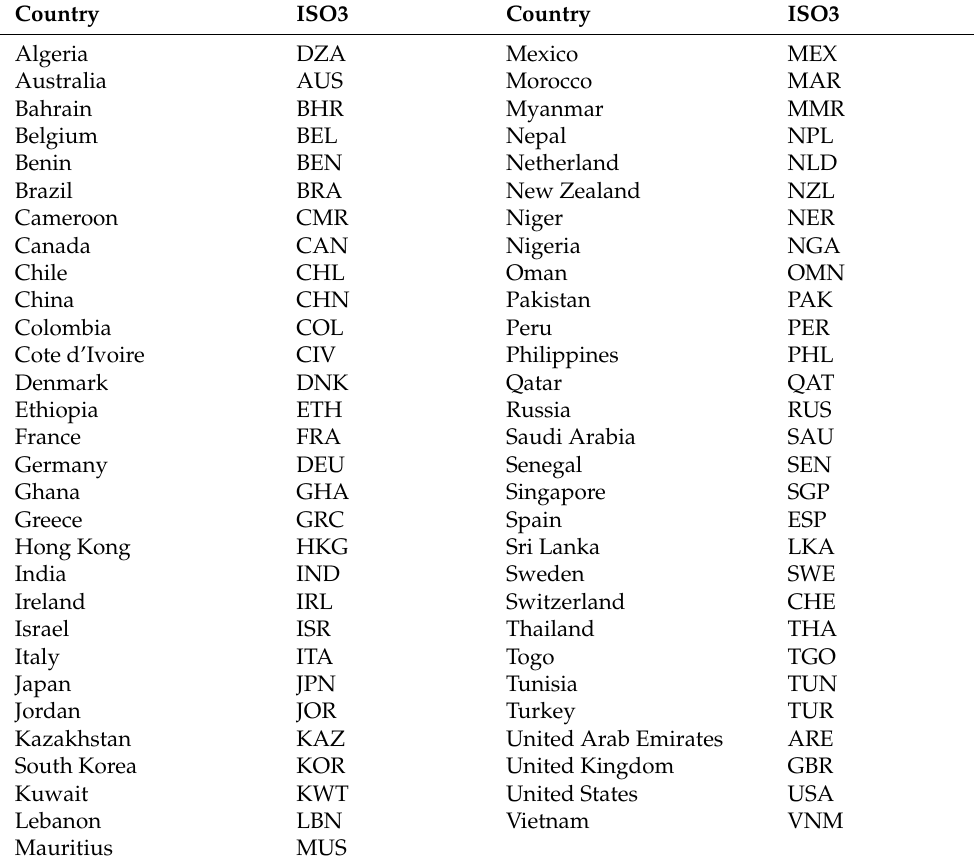
Table A1. List of Importing Countries.